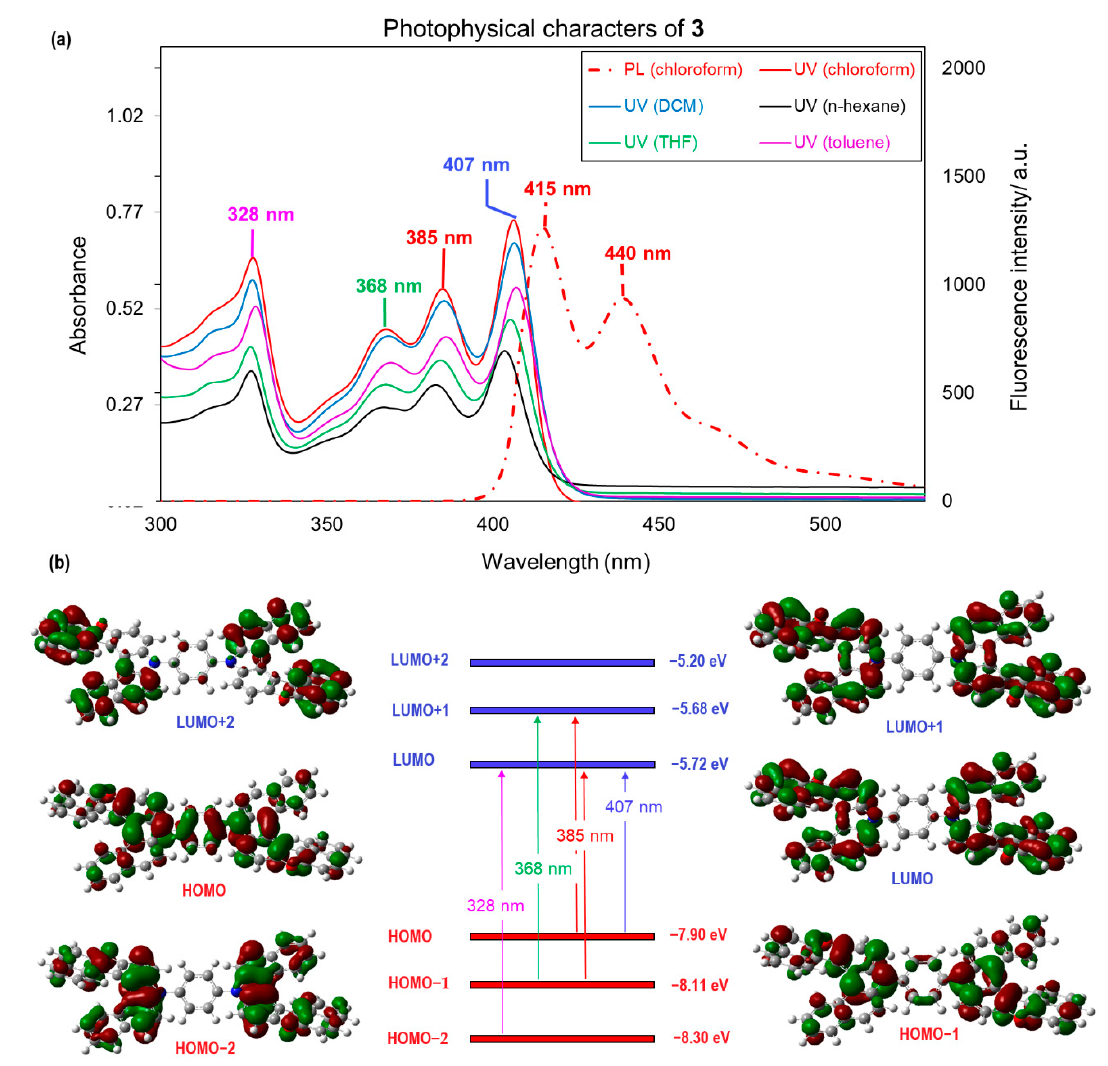
Figure 4. ( a ) UV/vis absorption and PL spectra of 3 in various solvents (20 µ M); ( b ) Frontier Kohn-Sham molecular orbitals of 3 and TD-DFT calculated electronic transitions at MN15/6-311G (d,p) level of theory.